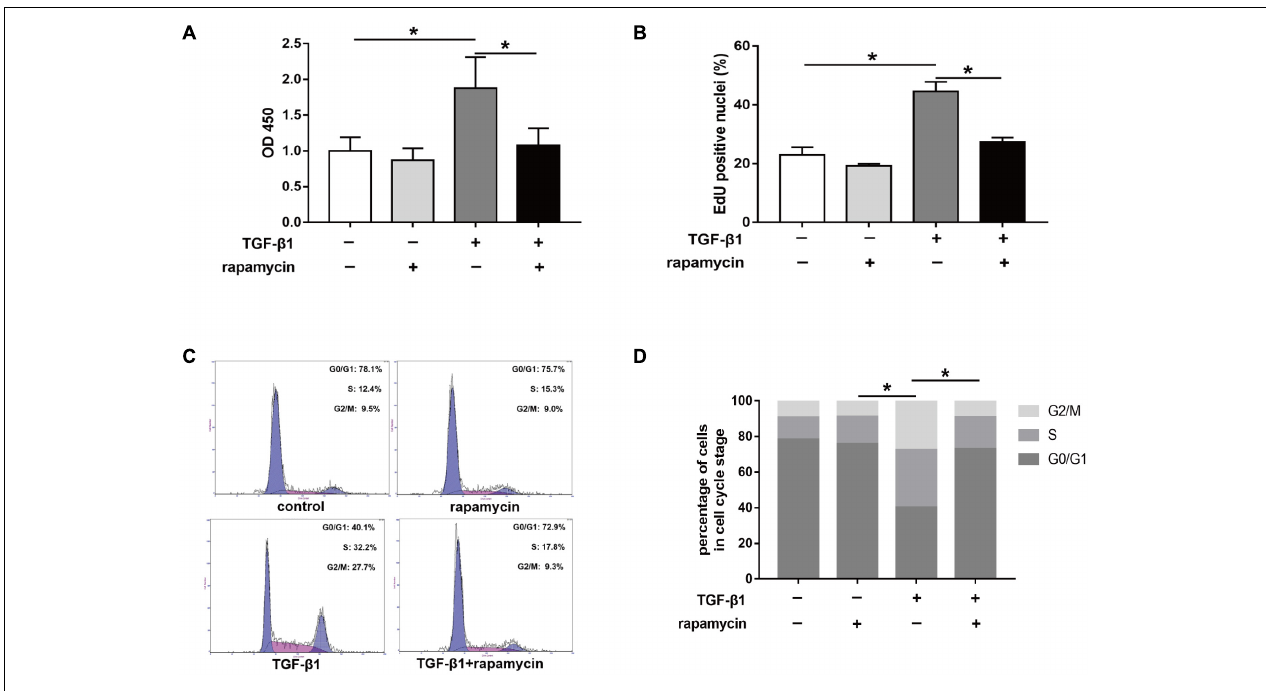
FIGURE 9 | Rapamycin treatment suppresses tenocyte proliferation. (A) CCK8 analysis of cell viability after treated with TGF- β 1 and/or rapamycin for 48 h. (B) Quantitative analysis of proliferative tenocytes by EdU staining after different treatments for 48 h. (C) Representative images of flow cytometry and (D) quantitative analysis of cell cycle distribution after different treatments for 48 h. Data are shown as the mean ± SD of three independent experiments. ∗ P <